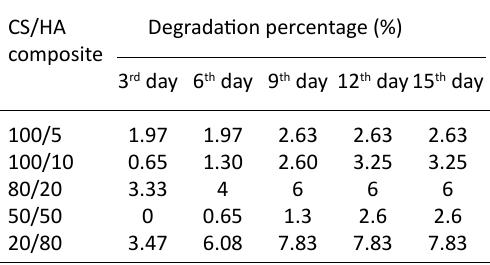
Table 2. Degradation of different ratios of nanocomposite by lysozyme in body fluid